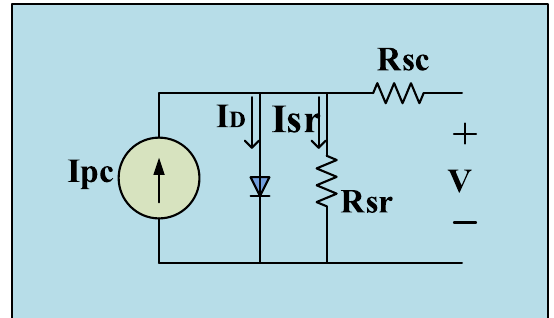
Fig. 5 Equivalent Circuit of Solar Cell. [5]